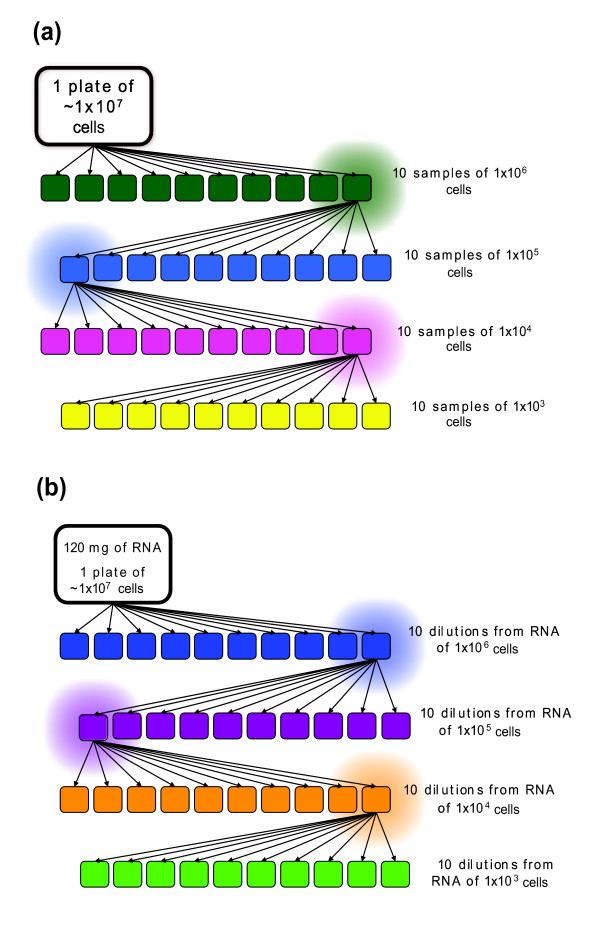
(a) Schematic outline of the cell culture serial dilution performed to validate our analytical model. A plate of SW620 cell culture was divided into 10 samples, each containing approximately 1 × 106 cells. One of these samples was selected at random and divided into a further 10 samples. The cell culture dilution scheme continues until 10 samples of 1 × 103 cells are achieved; there were a total number of 37 cell culture samples in our experiment. (b) Schematic outline of the RNA serial dilution that was used to control and estimate the error in our experimental data. RNA was first extracted from a plate of SW620 cell culture, then divided into 10 identical samples. One of these samples was selected at random to be further divided into 10 samples. A set of 37 controls corresponding to the cellular dilutions was obtained and used to estimate systematic variation in this analysis.